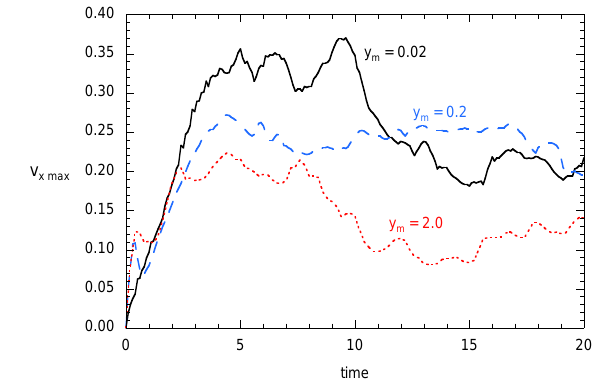
Fig. 11. Maximum earthward flow speed as function of time for bubbles with different widths y m = 0 . 02 (solid line), y m = 0 . 2 (dashed line), and y m = 2 . 0 (dotted line).